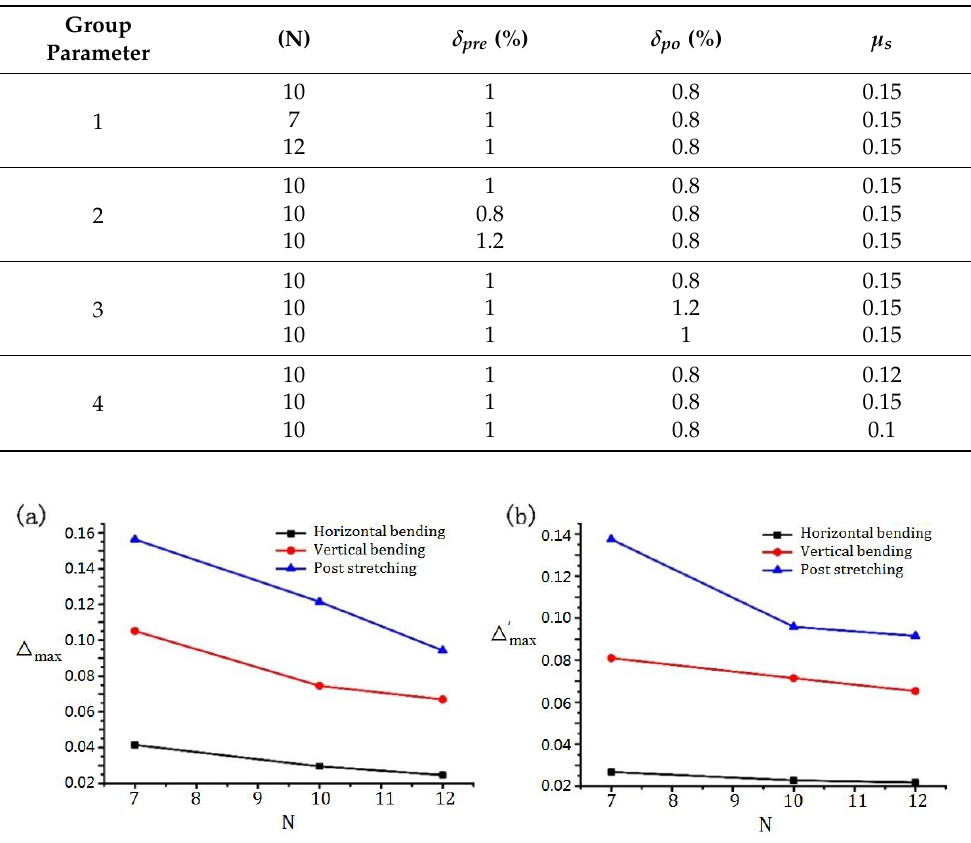
Table 4. Numerical simulation processing parameters settings.